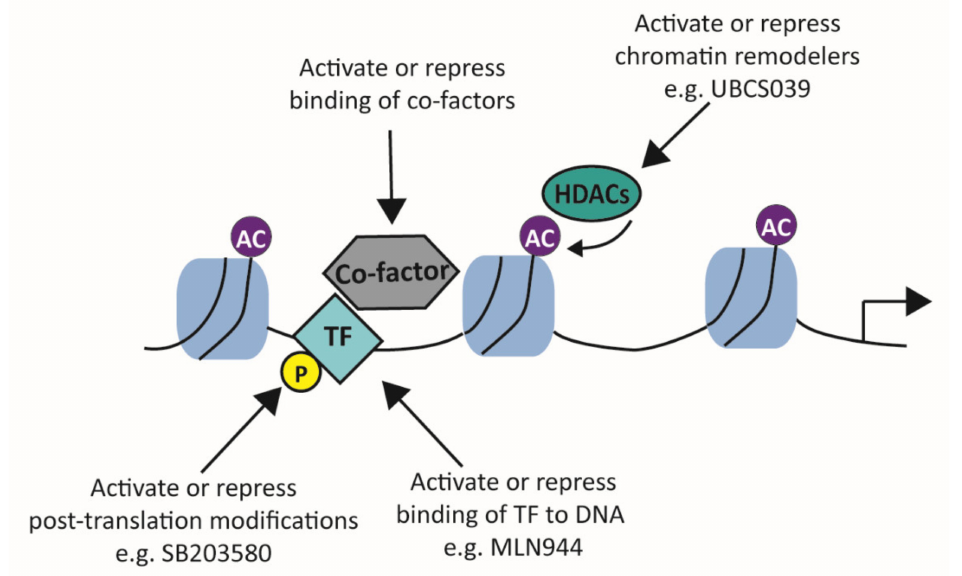
Figure 6. Possible therapeutic targets to regulate transcription factor function. There are di ff erent mechanisms that lead to transcription factor activation (or repression). Regulating these mechanisms can provide possible therapeutic